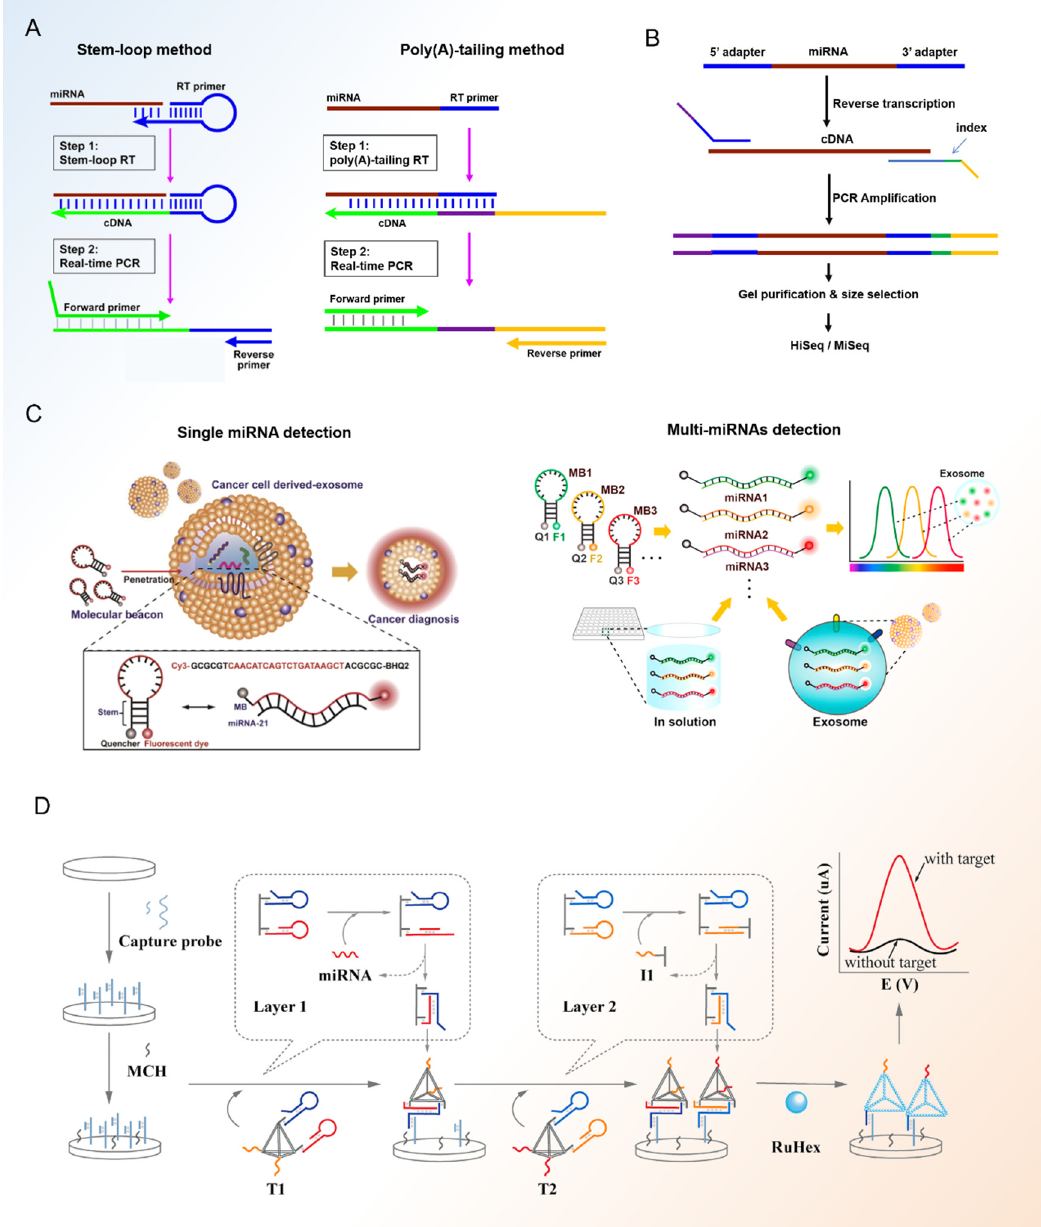
Figure 2. Detection approaches for breast cancer ‐ related exosomal miRNA analysis. ( A ) RT ‐ qPCR method for exosomal miRNA analysis, the length of miRNA was increased by stem ‐ loop (left) or poly ( A ) tailing (right) method [112]. ( B ) Flow chart for miRNA sequencing. The length of miRNA was increased by an adapter at both 3 ′ and 5 ′ sides. ( C ) Molecular beacon for single (left) [110] and multiple (right) [113] exosomal miRNA analysis. ( D ) Schematic representation of the electrochemical platform for exosomal miRNA detection